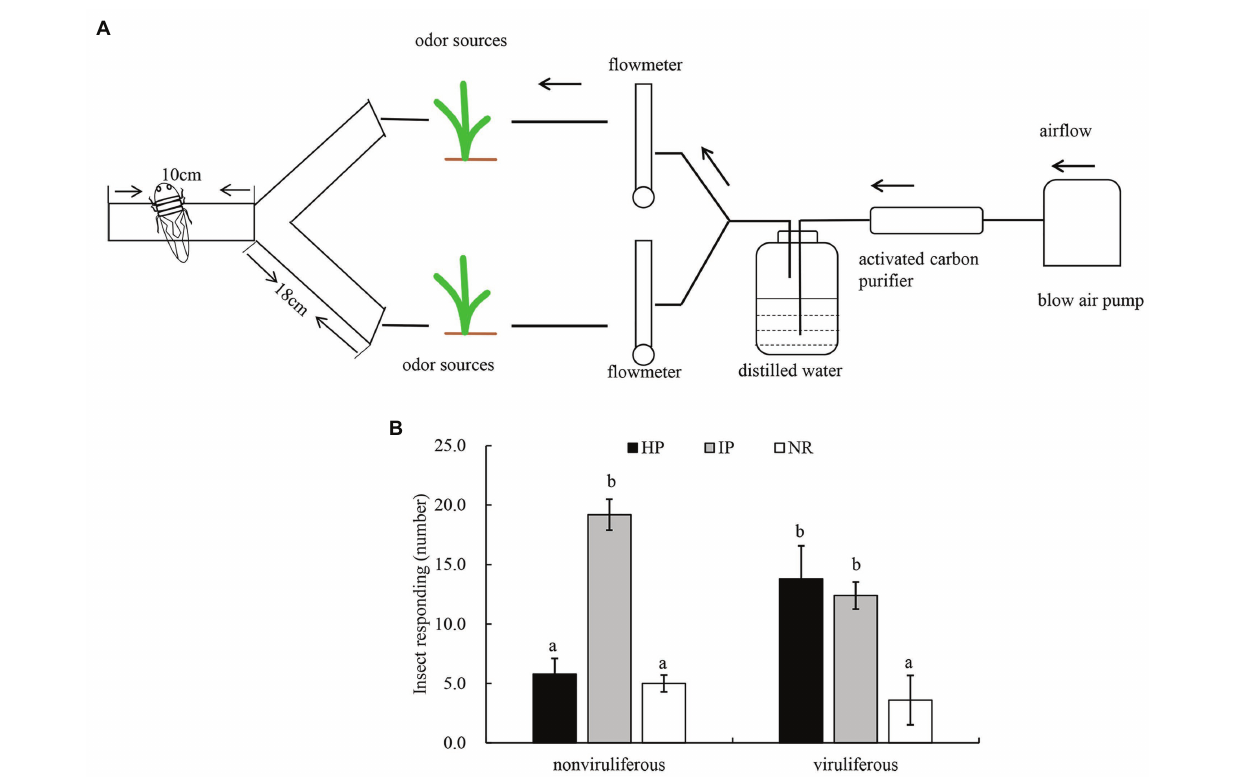
FIGURE 2 | The effect of odors emitted by virus-infected rice plants on the feeding tendency of R. dorsalis . (A) Y-tube olfactometer diagram. (B) Selective odor preference of viruliferous or nonviruliferous R. dorsalis adults to RGDV infected or healthy rice plants. Each experimental group comprises 30 adults and is repeated five times in total. Viruliferous, viruliferous R. dorsalis ; nonviruliferous, nonviruliferous R. dorsalis ; HP, healthy plant; IP, infected plant; NR, no responding. Bars represent means ± SE.